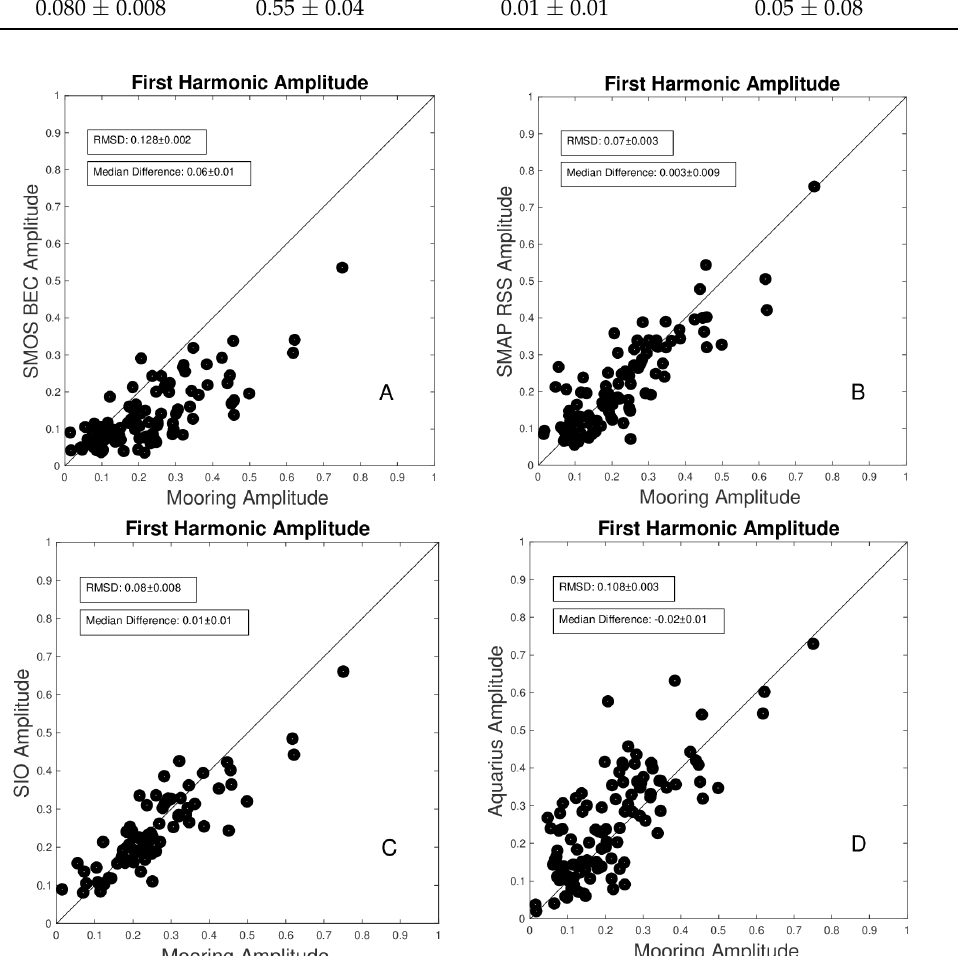
Figure 9. Scatterplots of first harmonic amplitude vs. mooring amplitude. A light black line shows a one-to-one corre- spondence. Boxes in each panel show RMSD and median difference (mooring-comparison). Comparison amplitudes are ( A ) SMOS BEC, ( B ) SMAP RSS, ( C ) SIO, ( D ) Aquarius. For completeness, all first harmonic amplitude comparisons are shown in the supplemental materials (Table